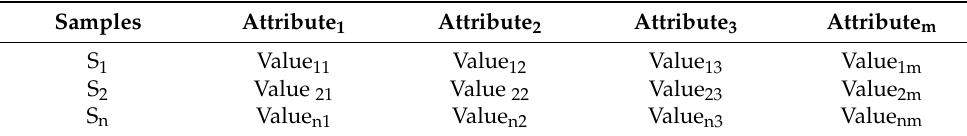
Figure 7. Scheme of a diagnostic classifier based on causal relations in FBBNs using RDPs. Table 2. Relational Data Table